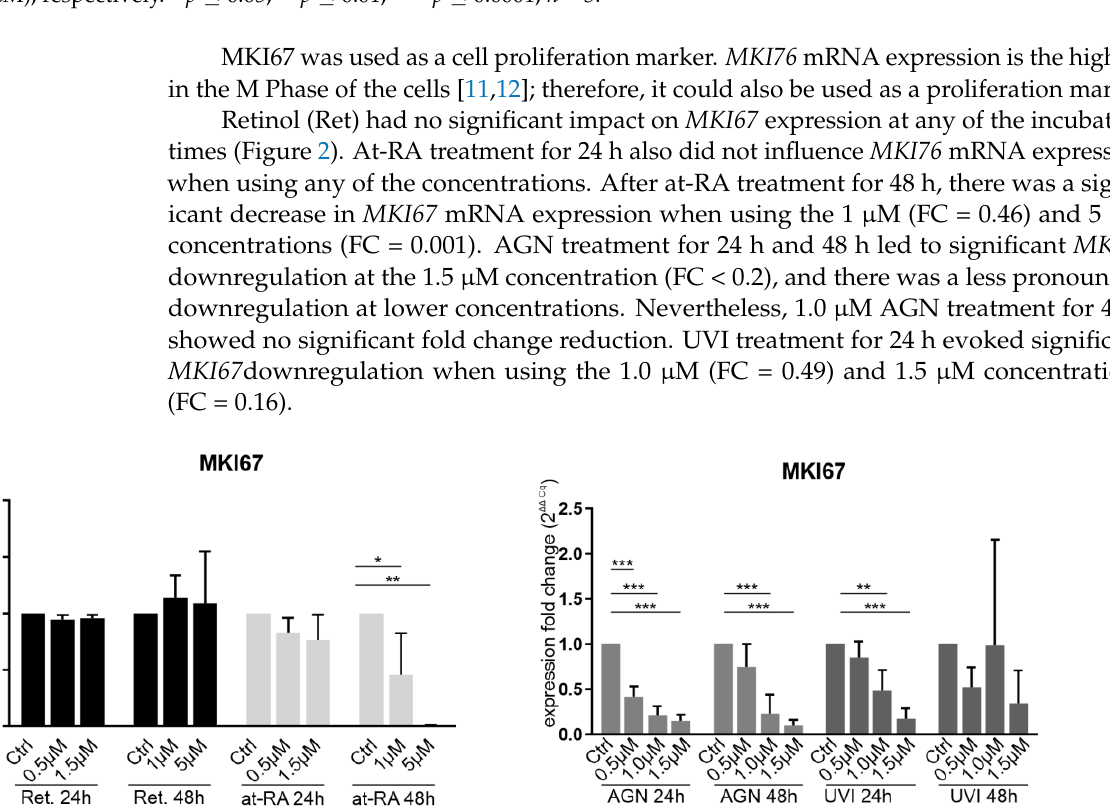
Figure 1. XTT viability assay of primary LEC treated with retinol (Ret), all trans-retinoic acid (at-RA), AGN 193109 (AGN), or UVI 3003 (UVI) for 24 h and 48 h at increasing concentrations (controls without treatment) of 100 nM, 500 nM, 1 µM, 1.5 µM, 5 µM), respectively.* p ≤ 0.05; ** p ≤ 0.01; **** p ≤ 0.0001; n = 3.